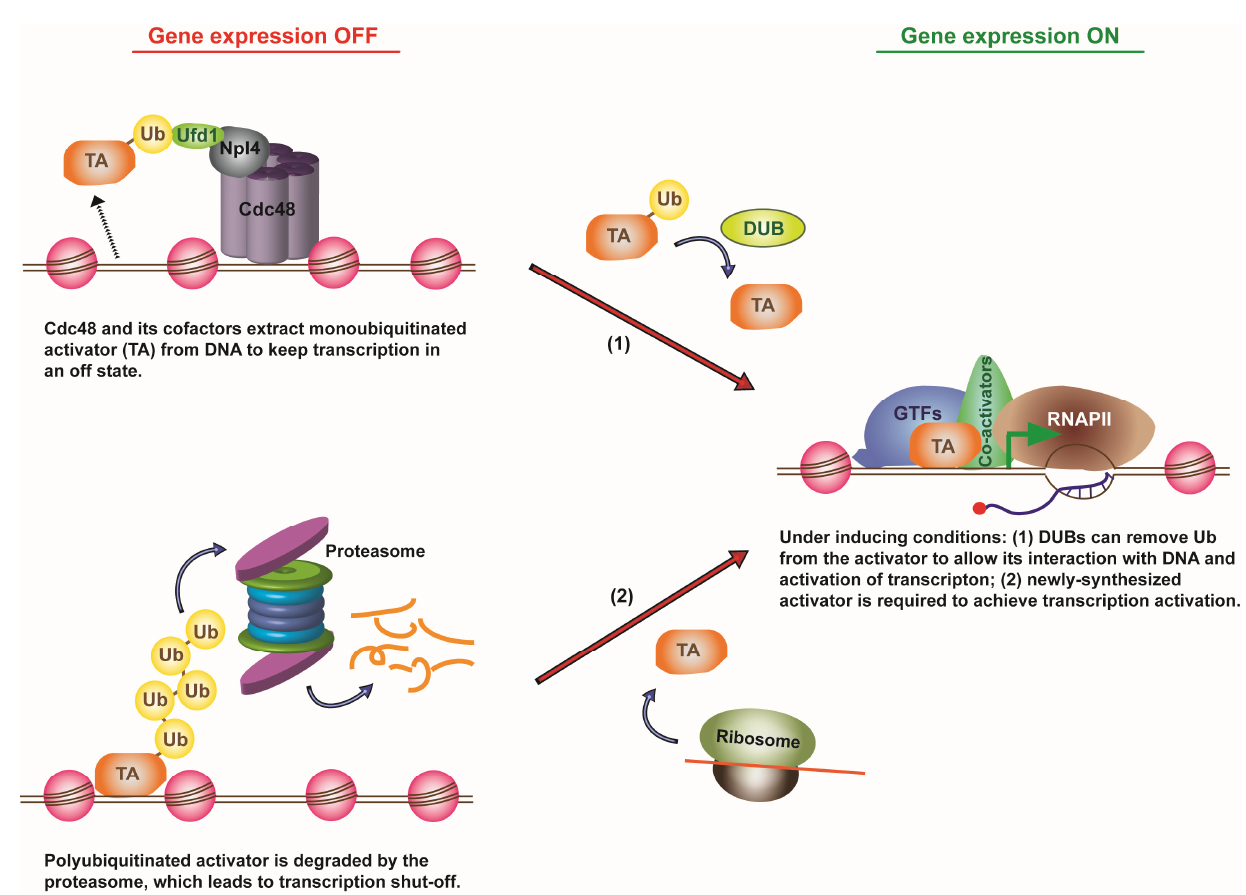
FIGURE 1: Ubiquitination of transcription activators downregulates transcription through multiple